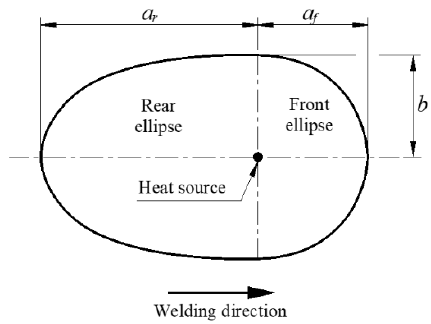
Figure 4. Schematic representation for the double ellipse heat source configuration, reproduced from [22] with permission from Elsevier, 2020.